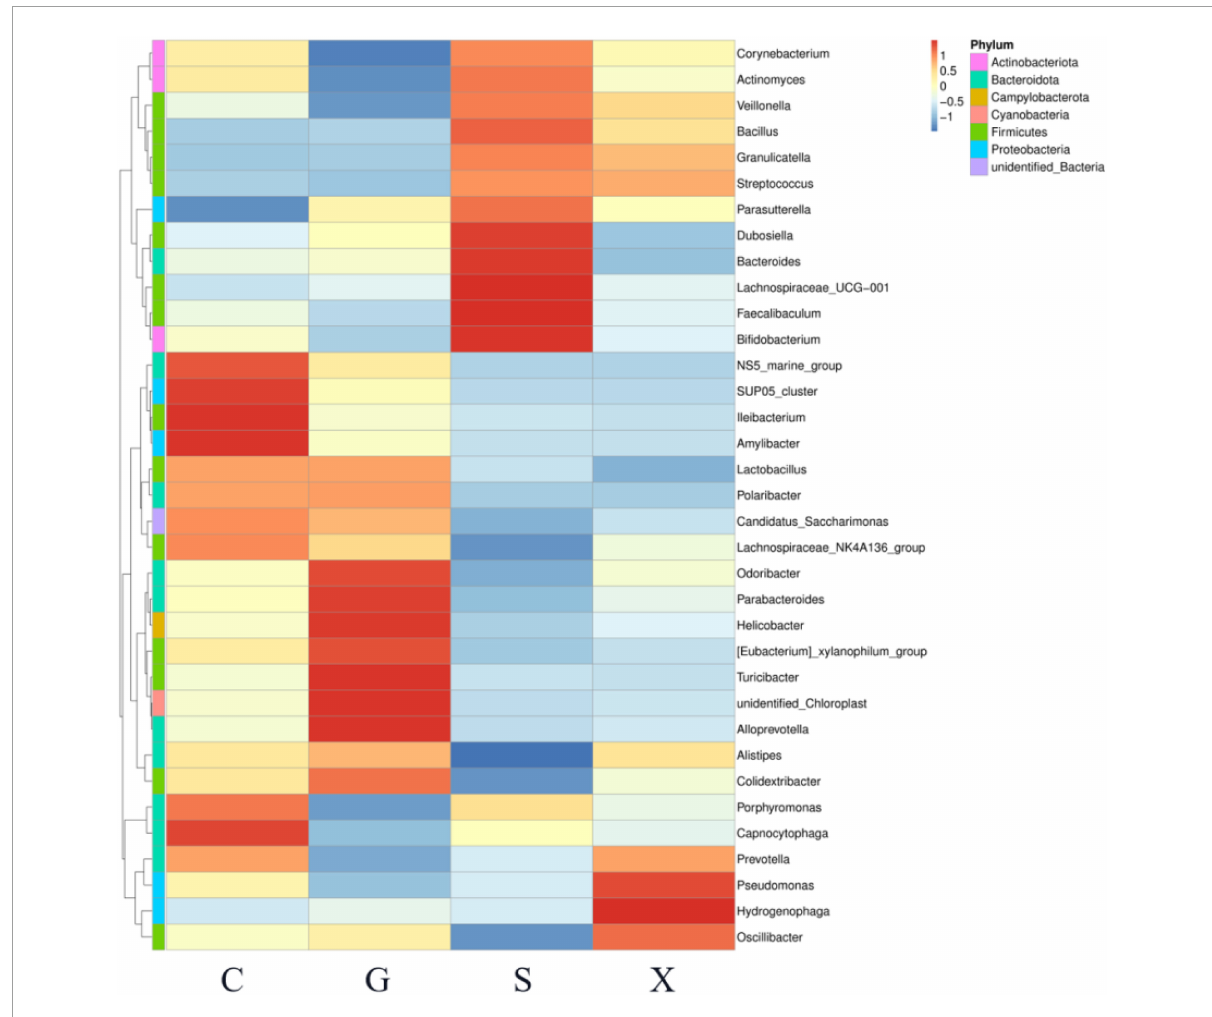
FIGURE7 The relationship between the relative abundance of the top 35 genera in the gut microbiota of mice with reactivation of Toxoplasma gondii infection at 7 dpi. C: no T. gondii + DEX + PBS; G: 3 T. gondii cysts + DEX + PBS; S: 3 T. gondii cysts + DEX + koumiss; X: 3 T. gondii cysts + DEX + mare’s milk. All data are expressed as mean ±